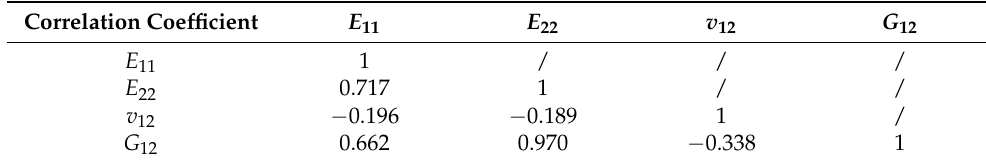
Table 16. Correlation coefficients between the stiffness properties of H-GFRPs under the RTD condition.